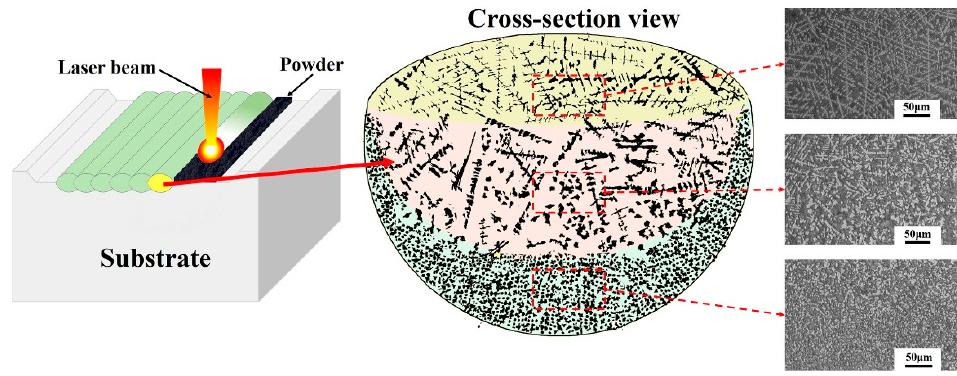
Figure 11. Change morphology of precipitations in coatings (30ZrN).